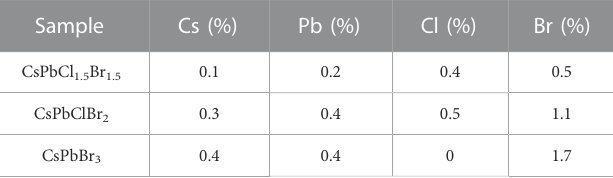
are shown in Supplementary Figure S1B. Absorption spectra are also TABLE 1 Atomic percentages of Cs, Pb, Cl and Br for the three CsPbX 3 samples,